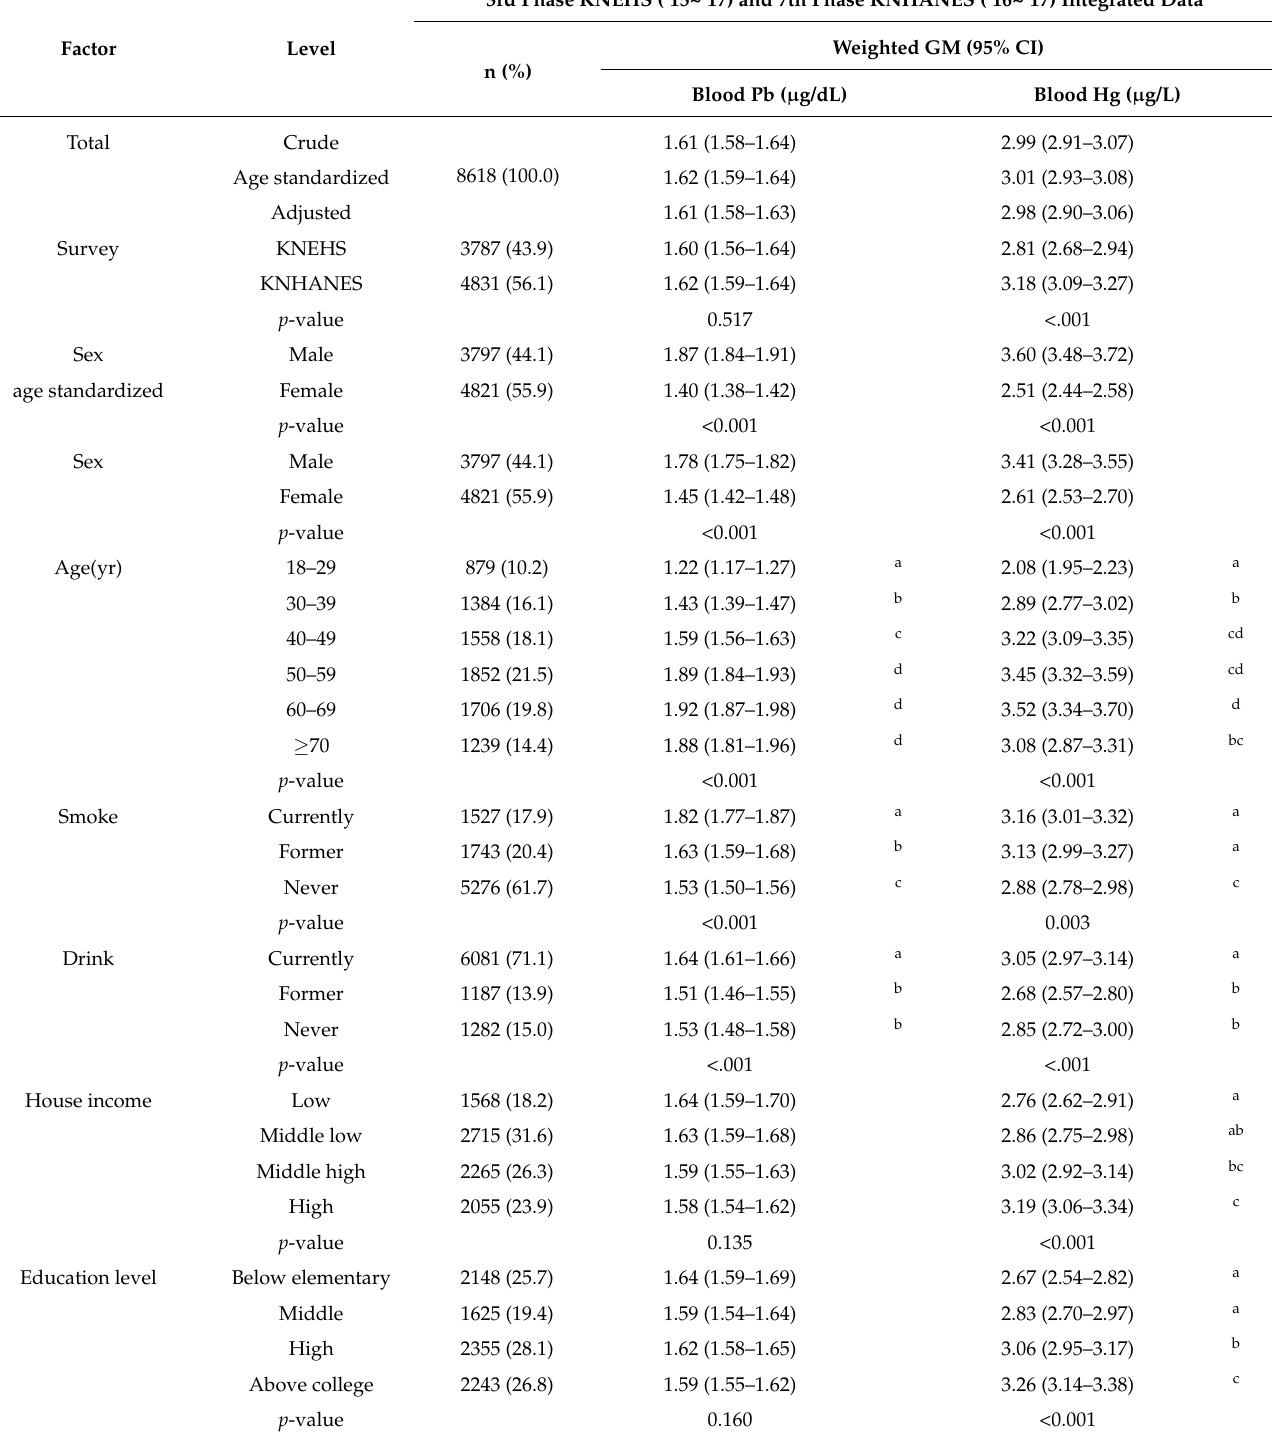
Table 2. Blood lead and mercury concentration by characteristics using integrated data recent